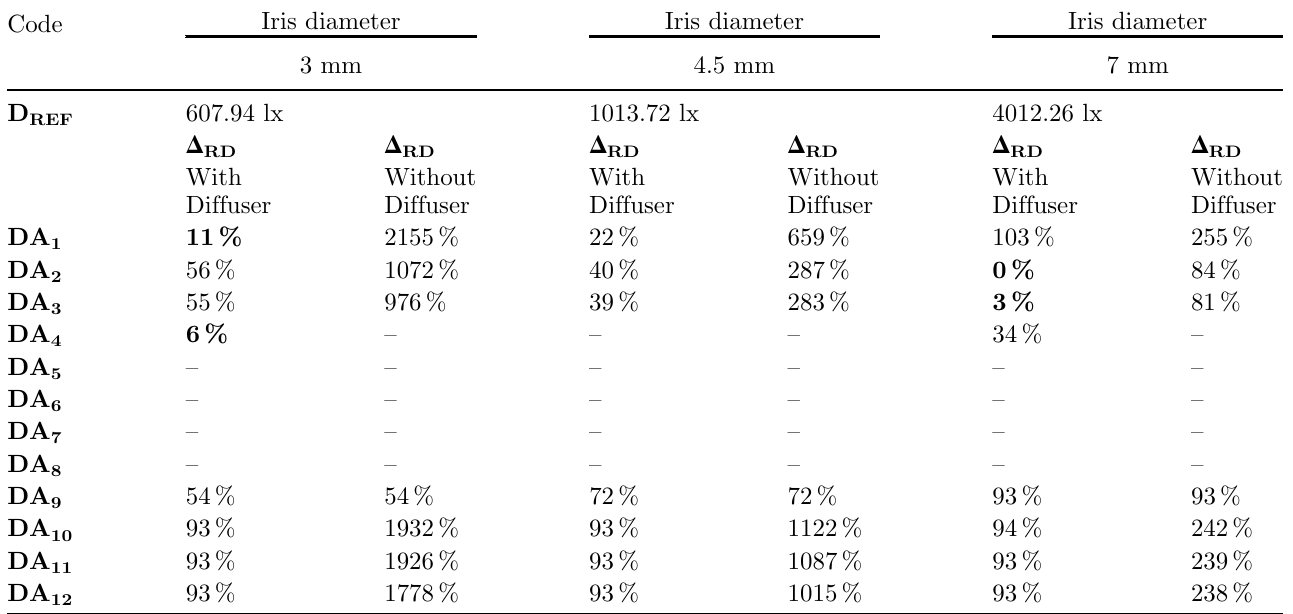
Table 3. Relative percentage difference ( D RD ) between mean values of device/app combination illuminance results and the reference illuminance for three illuminance levels at distinct opening diameters of an